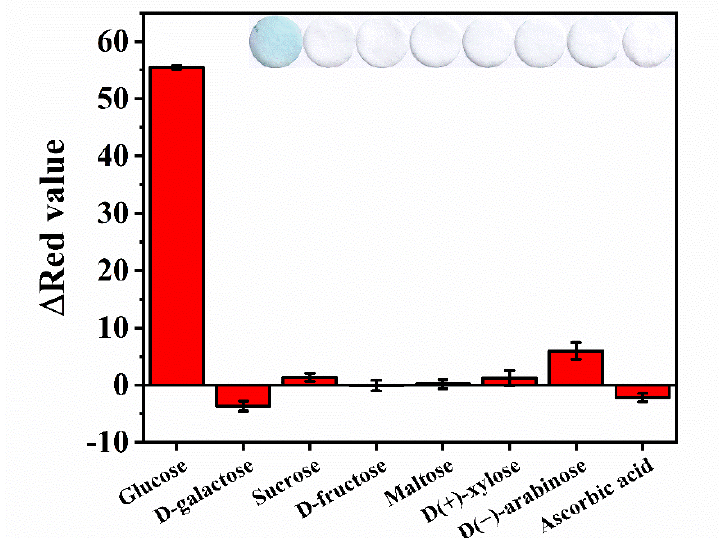
Figure 6. Color intensity response in the presence of different sugars and ascorbic acid.